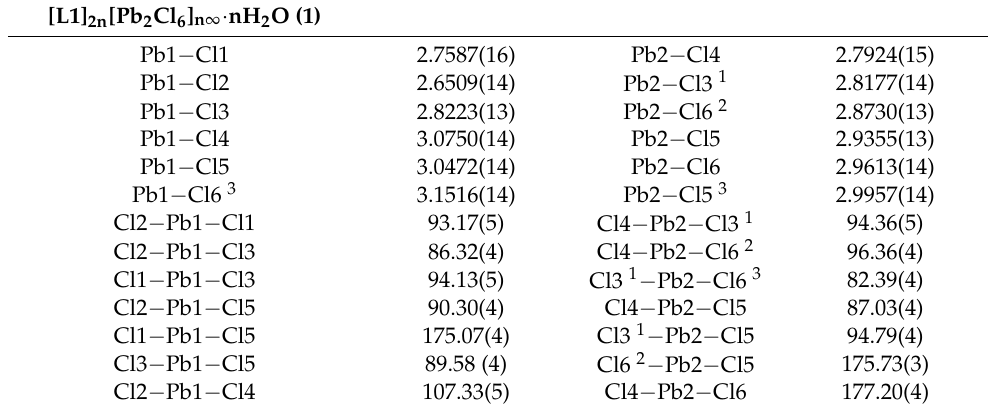
Table 2. Selected bond lengths (Å) and angles ( ◦ ) in 1 − 3 [a]